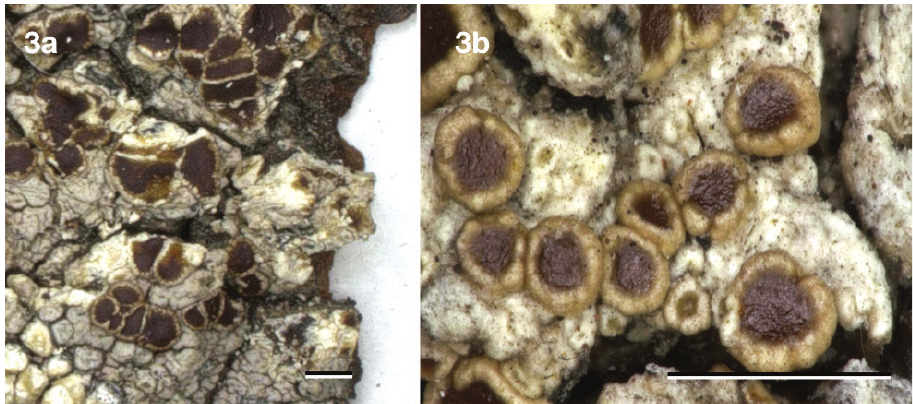
Figure 3. Maronina australiensis (type species of Maronina ), holotype Hafellner 17823 & Rogers (GZU). Scale bar: 1